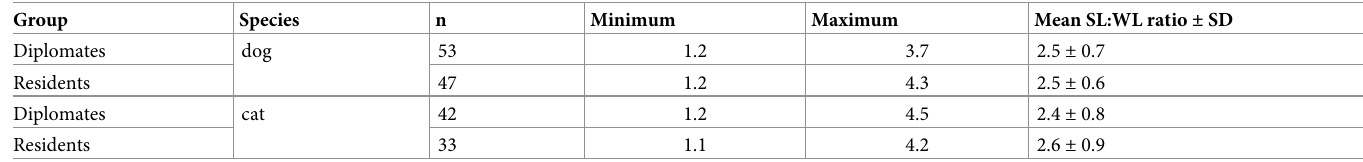
Table 2. Minimum and maximum ranges of the SL:WL ratio and mean SL:WL ratio ± SD separated by groups and species. Group